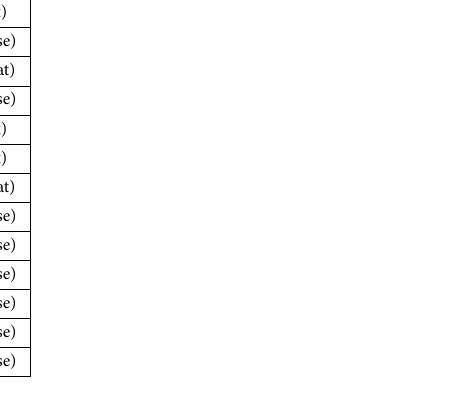
Table 2. Western blot